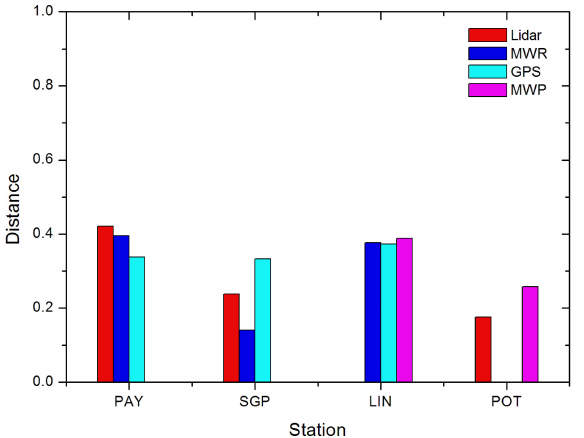
Figure 5. Comparison of the statistical distances between pairs of times series data retrieved for the instruments measuring integrated water vapour with respect to the time series obtained from the ra- diosondes at the Lindenberg (LIN), Payerne (PAY), Potenza (POT), and Southern Great Plains (SGP) sites. The data set considered in- cludes all available measurements in 2010–2012.